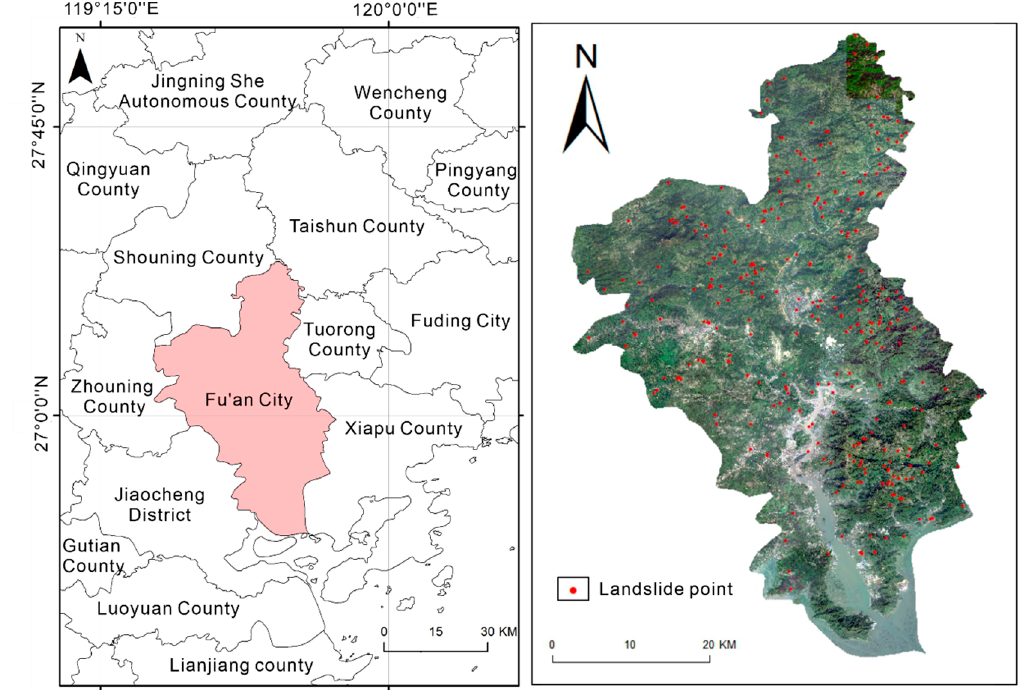
Figure 1. Geographical location and landslide location map of Fu’an.